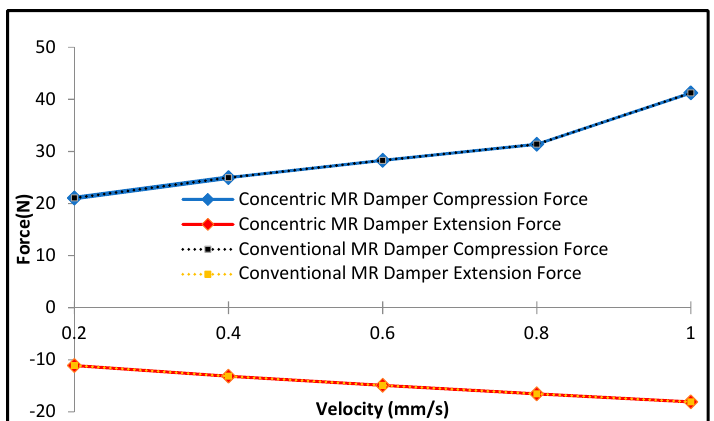
Figure 10. On-state damping force.